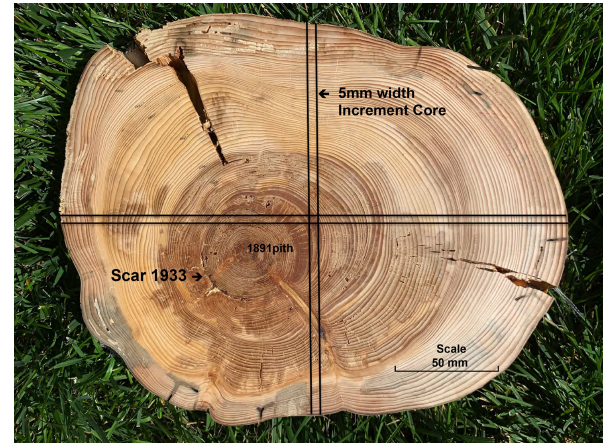
Figure 4. Example of cross section sample where four cores taken uphill, downhill, and perpendicular (2) would have missed at least one scar (1933) and potentially the pith of the tree. The black lines indicate the potential cores using a 5mm width increment borer. Note the scale on lower right of